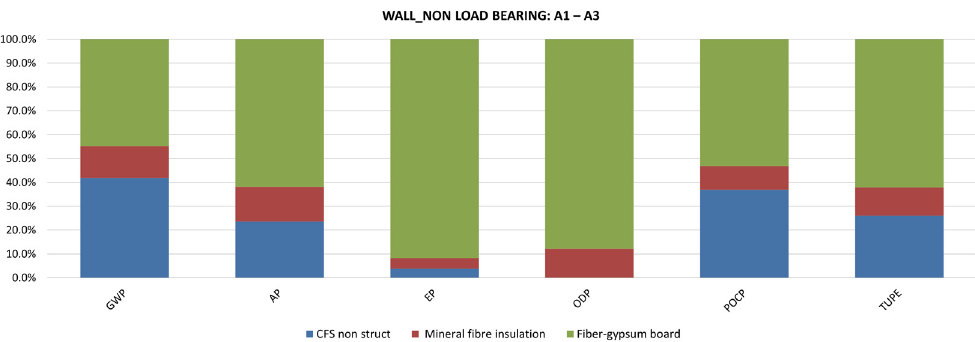
Figure 11. LCIA results: load-bearing walls. Table 12. Results of Life Cycle impact assessment: load-bearing walls.